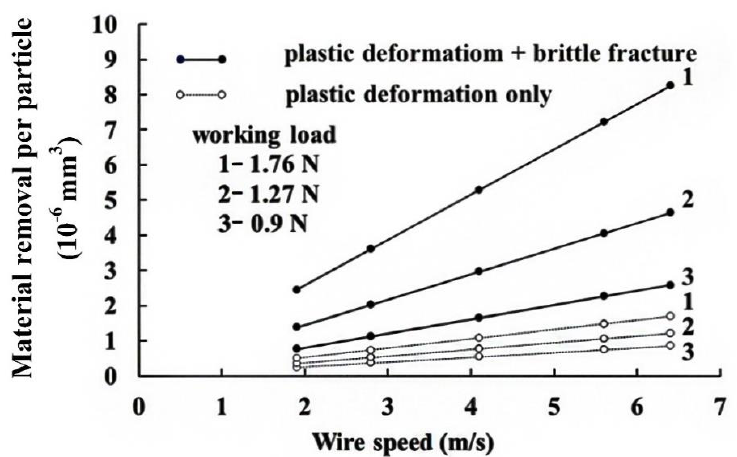
Figure 8. Theoretical value for material removed by a single grit.